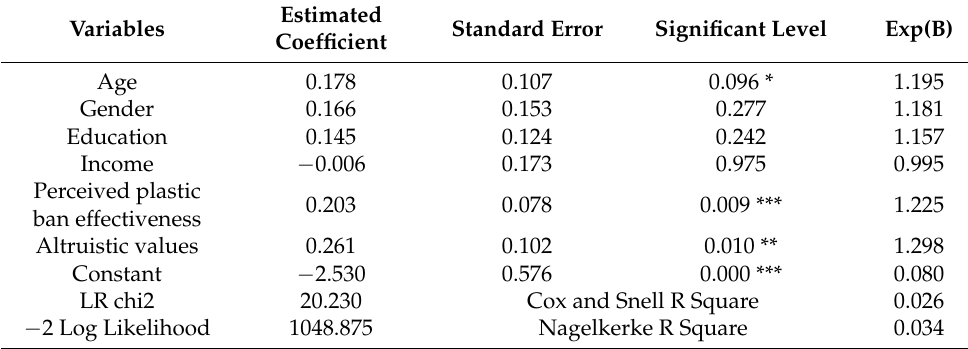
Table 3. Estimated Logit model for people’s old plastic bag usage